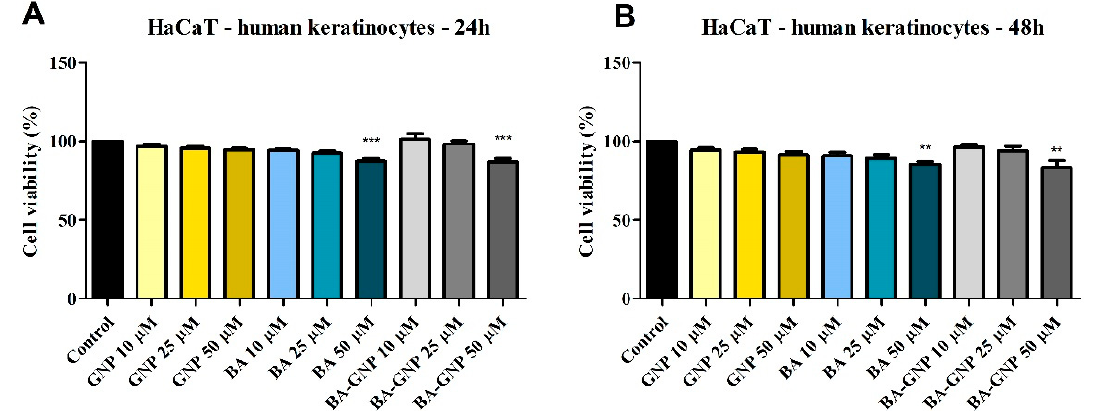
Figure 6. Cell viability of HaCaT cells after 24 h ( A ) and 48 h ( B ) treatment with GNP (diluted to match the same gold content as for BA loaded NPs at 10, 25 and 50 µ M), BA and BA-GNP (10, 25 and 50 µ M). The results are expressed as cell viability percentage (%) normalized to control (100%). The data represent the mean values ± SD of three independent experiments performed in triplicate.